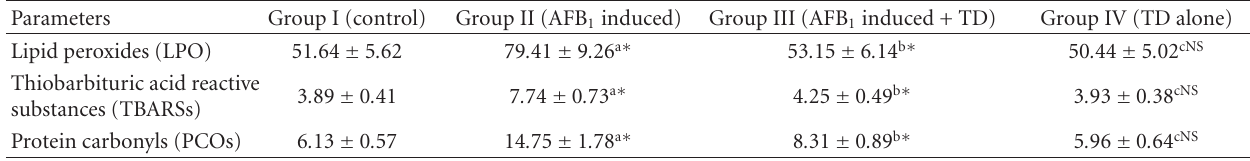
Table 1: E ff ect of TD on indicators of macromolecular damage in liver of control and experimental animals.